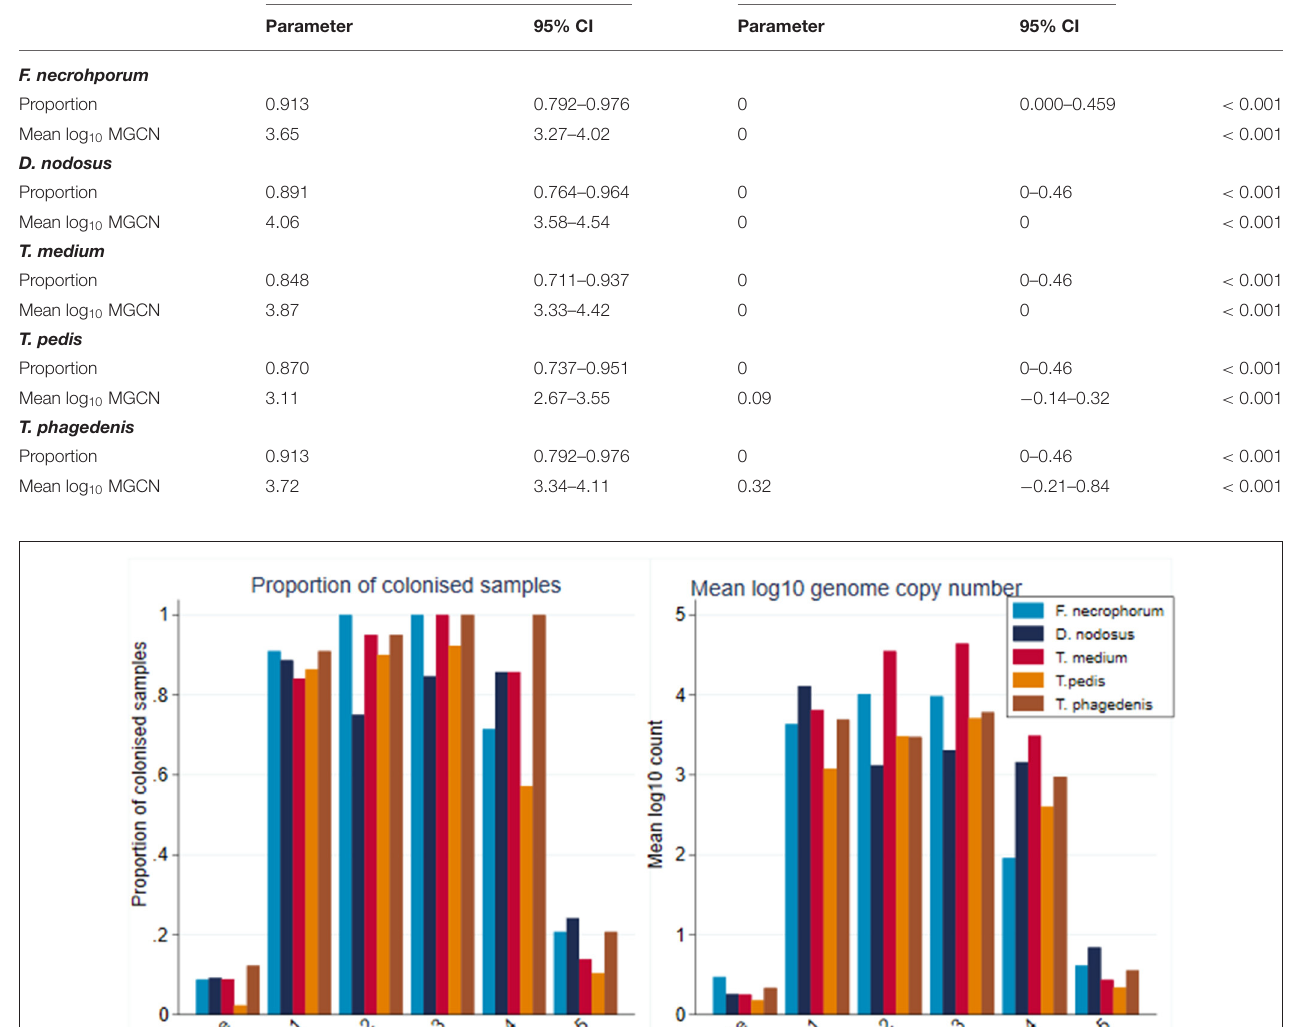
TABLE 3 | Bacterial colonization of G#1 CODD lesions by previous lesion history. Bacterium